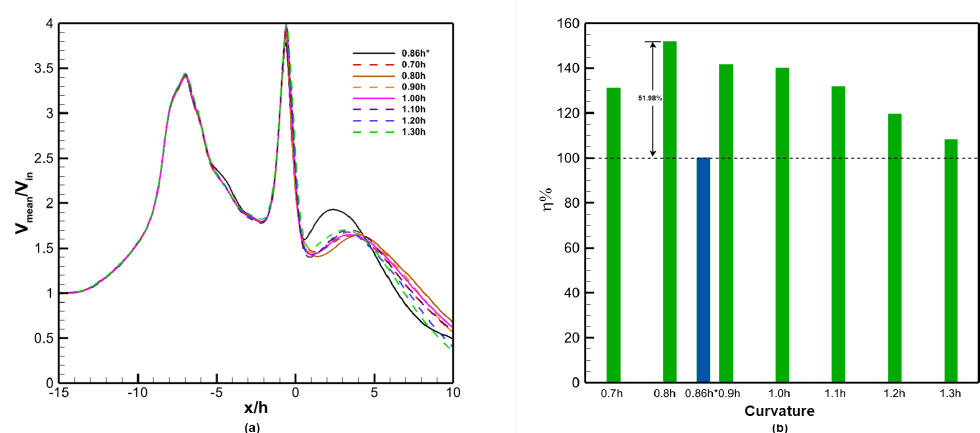
Figure 8. ( a ) Mean velocity along the centerline normalized by the inlet velocity, V in , Baseline ; ( b ) velocity ratio, η , at point x/h = 5 for the curvature